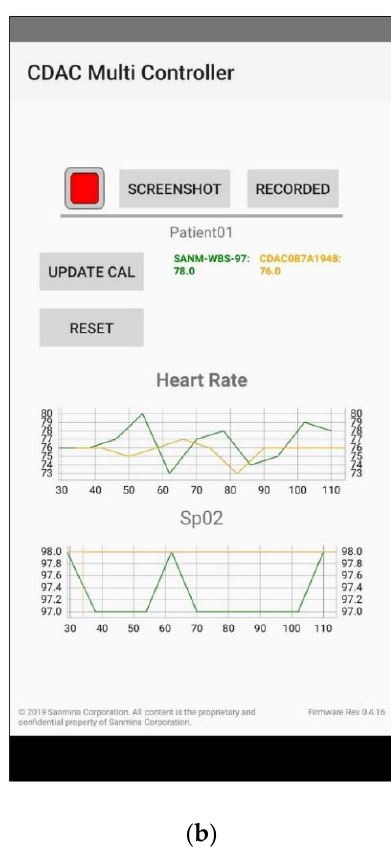
Figure 20. Smartphone application for SpO 2 and heart rate measurements ( a ) smartphone app in a user’s hand, ( b ) screenshot of the measured plots.